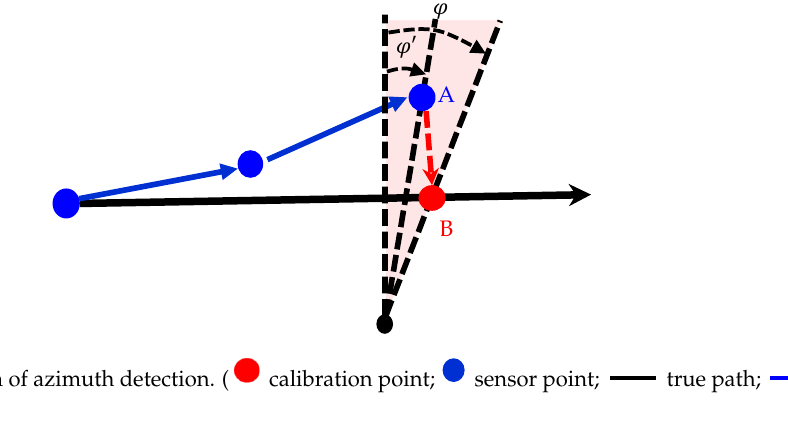
Figure 8. Diagram of distance detection. ( calibration point; sensor point; true path; sensor path.)